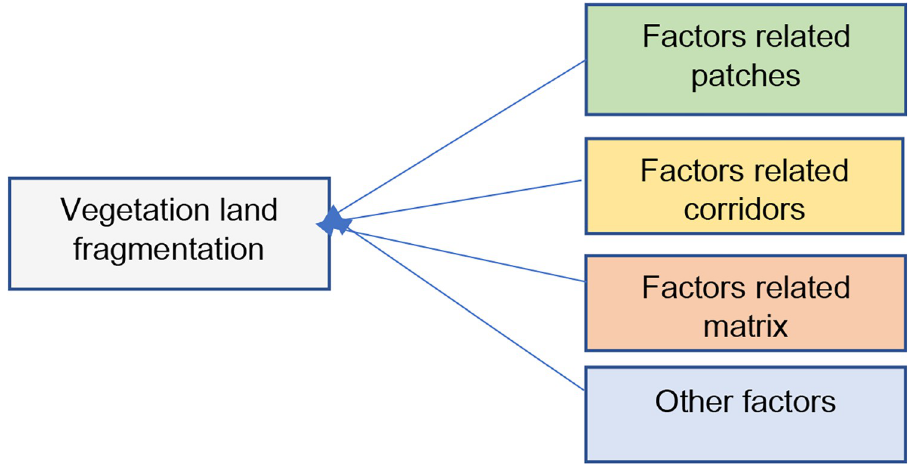
Fig 3. Conceptual framework.